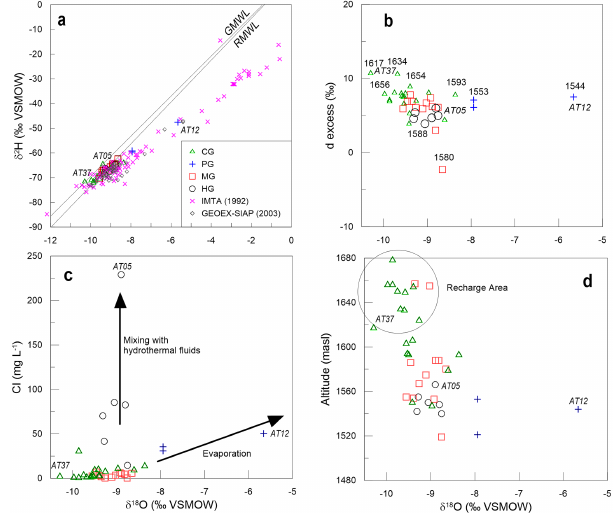
Figure 6. (a) Deuterium and oxygen-18 in groundwater from the Atemajac–Toluquilla aquifer system using well groups and results from previous studies; (b) oxygen-18 vs. deuterium excess with la- beled altitudes; (c) oxygen-18 vs. chloride concentration; and (d) oxygen-18 vs. altitude. Note: GMWL represents the Global Me- teoric Water Line (Rozanski et al., 1993); RMWL represents the regional meteoric water line (Wassenaar et al., 2009); IMTA rep- resents Instituto Mexicano de Tecnología del Agua, GEOEX rep- resents Geología y Exploraciones and SIAPA represents Sistema Intermunicipal para los Servicios de Agua Potable y